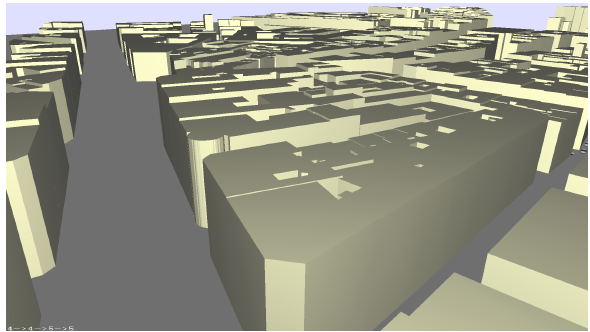
Figure 1: LOD1 3D city model (Paris VI). Source: IGN c (cid:13) BD TOPO.